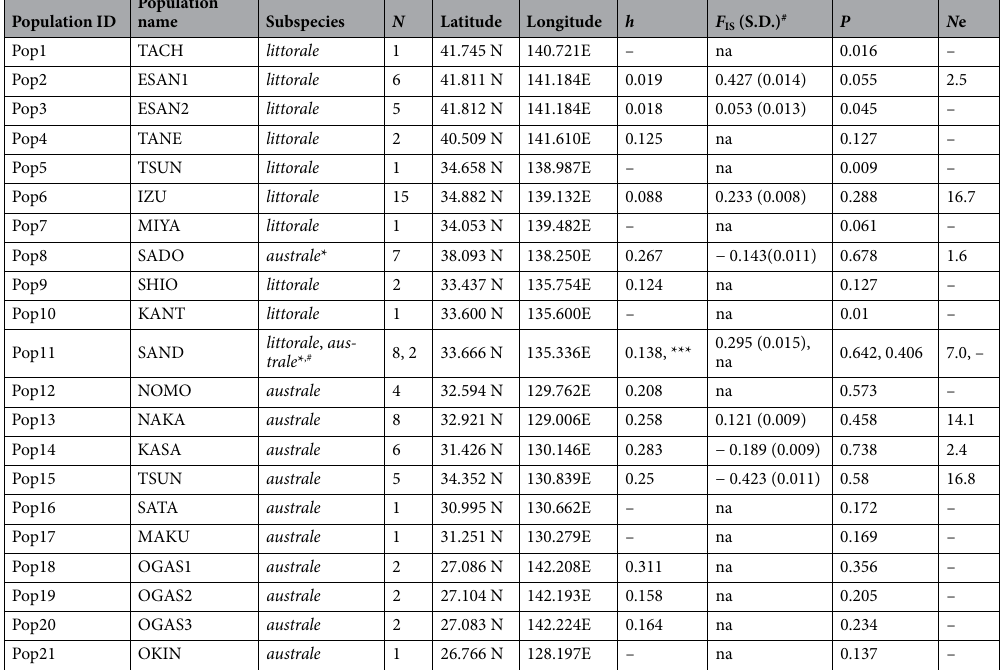
Table 1. Sampling location and gene diversity of C. falcatum subsp. australe and subsp littorale populations. N number of samples, h gene diversity, F IS inbreeding coefficient, P proportion of polymorphic loci, N e effective population size. * Samples of Pop8 and 11 were originally collected as subsp. littorale based on the distribution information of the two subspecies in Japan 8 , but subsequent analyses suggested that some of them belong to subsp. australe . # Values of the two subspecies in Pop11 are shown separated by a comma.